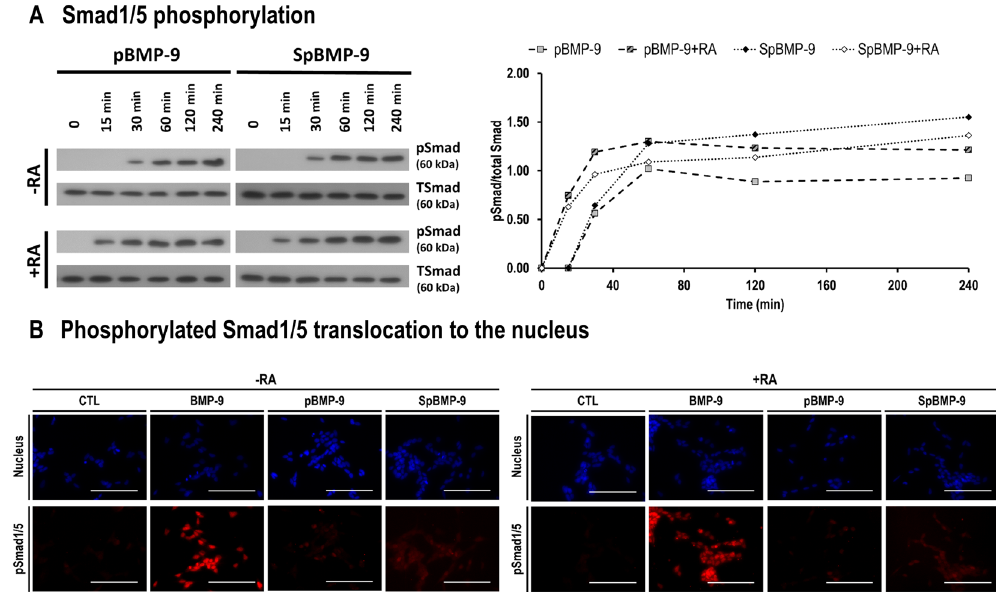
Figure 1. Effect of pBMP-9 and SpBMP-9 on the activation of the canonical Smad1/5 pathway. ( A ) Western blots of phosphorylated Smad1/5 (pSmad) and densitometric analysis of pSmad1/5 as referred to total Smad (TSmad) showing the effect of 1 nM BMP-9, pBMP-9 and SpBMP-9 + / − 10 μ M RA in SH-SY5Y cells after incubation for 0, 15, 30, 60, 120 and 240 min. ( B ) Pictures showing the nucleus (blue) and the pSmad1/5 (red) in SH-SY5Y cells stimulated with an equimolar concentration of BMP-9, pBMP-9 or SpBMP-9 (1 nM) + / − 10 μ M RA after incubation for 240 min. Results are representative of 2 independent experiments performed in duplicate (Bar = 100 μ